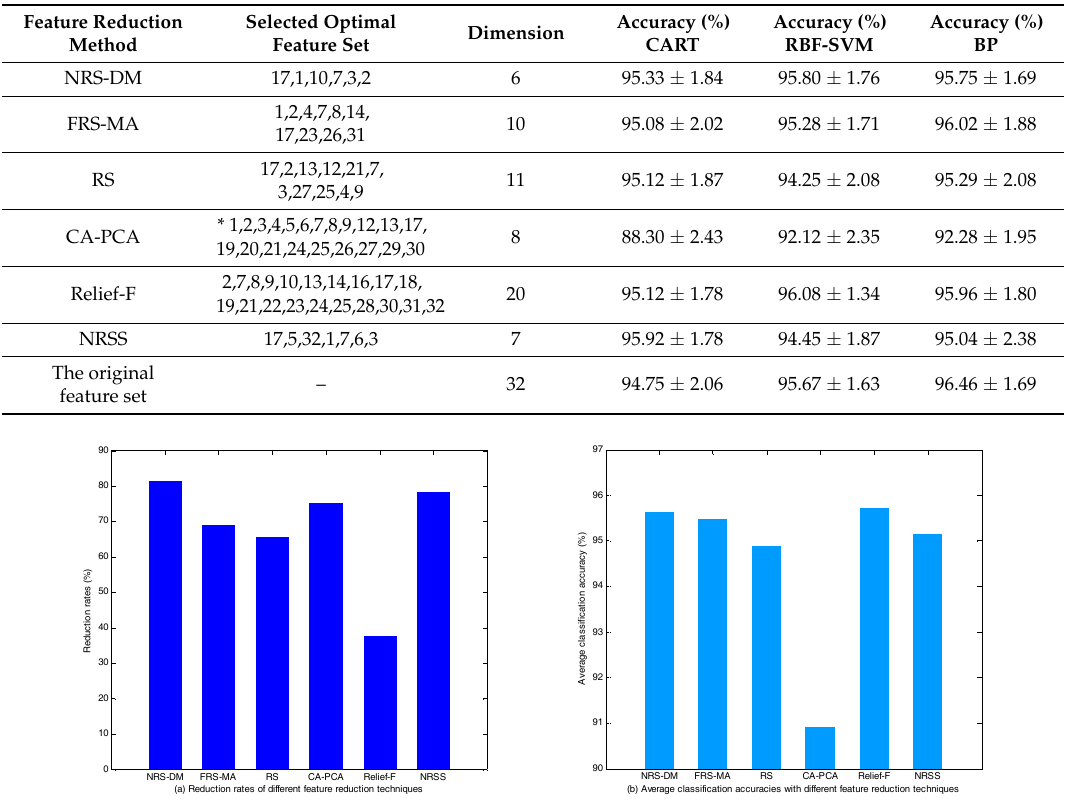
Table 3. Comparison of different feature reduction methods (NES39).